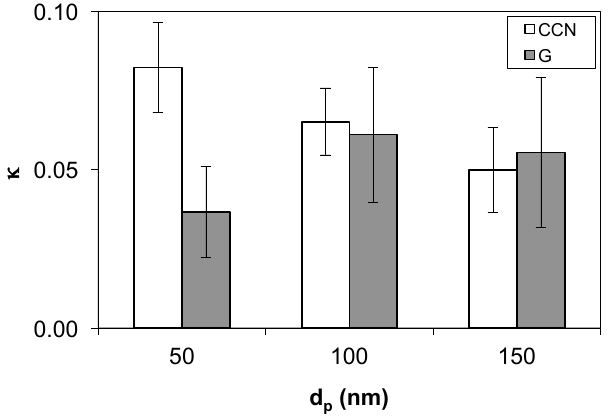
Fig. 3. Grand averages (of all nine experiments) of hygroscopicity parameters derived from hygroscopic growth factors (κ G ) shown as gray bars and from CCN spectra ( κ CCN ) shown as white bars. The error bars correspond to 1 standard deviation of the data.